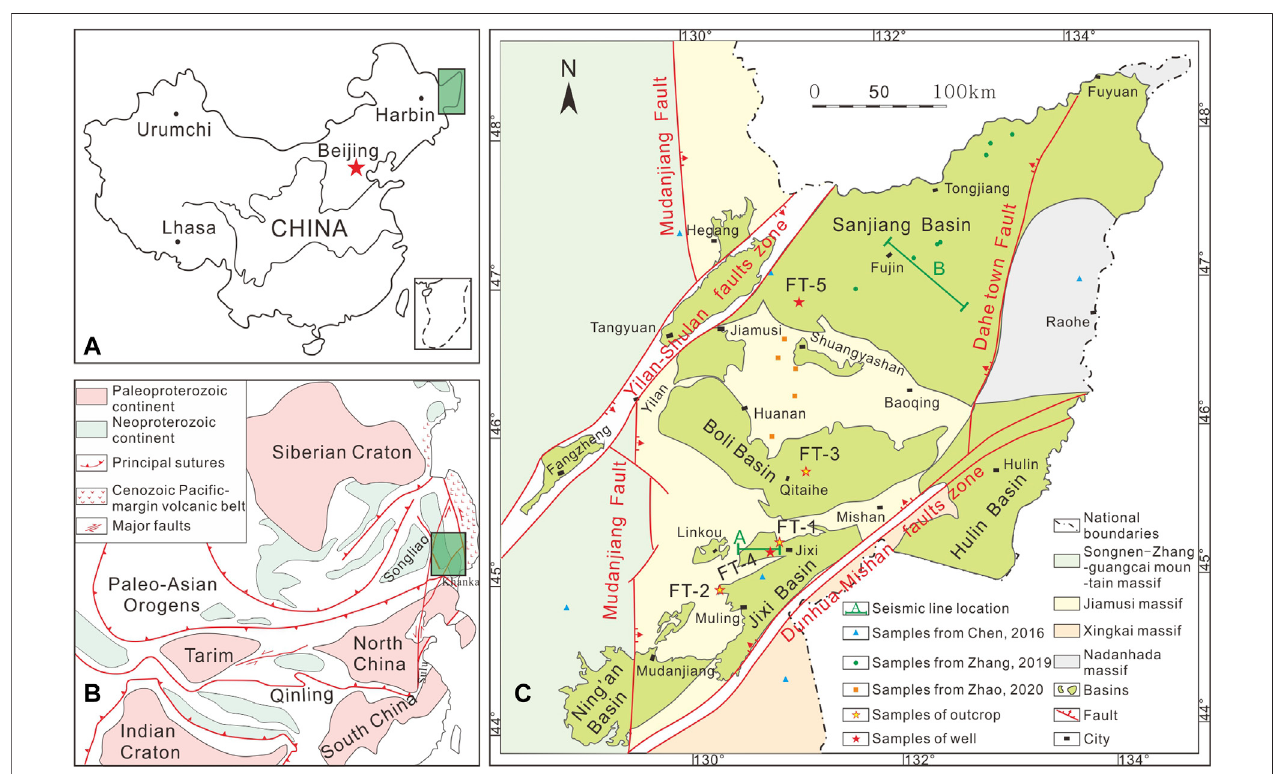
FIGURE 1 | (A) Schematic geographical location of Dasanjiang area (after the map of China). (B) Schematic tectonic map of Asia indicating the position of the Dasanjiang basin (modi fi ed after Safonova et al., 2009; Zhou et al., 2020). (C) Basin distribution and sampling location in Dasanjiang region, NE China (modi fi ed after Zhang Y. P. et al., 2012; Chen, 2016; Zhang et al., 2016; Zhang, 2019; Zhao, 2020; Zhou et al.,